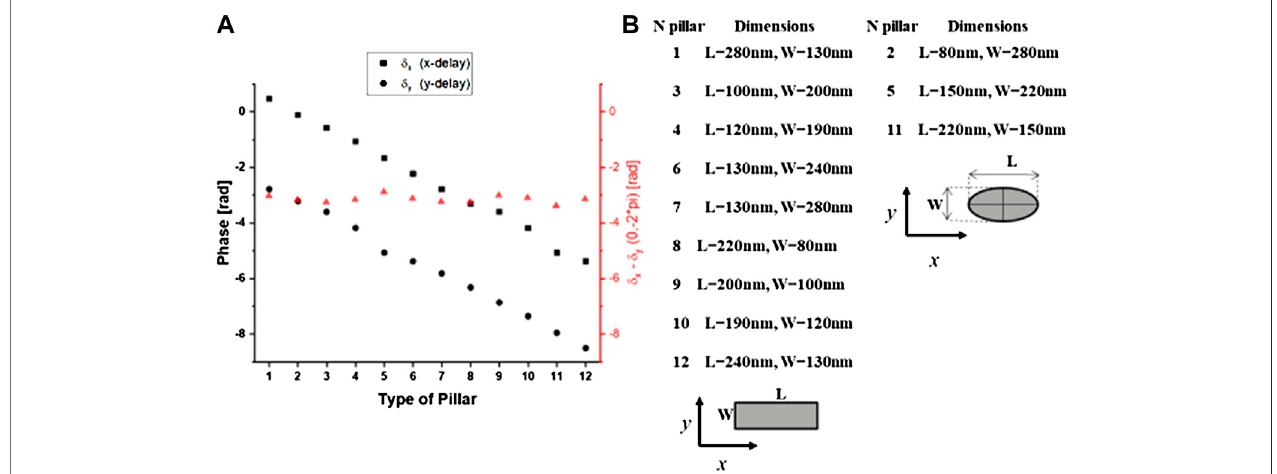
FIGURE 3 | (A) Graph showing the library of different pillars working at 775 nm and their phase delays under both TE polarization ( x -delay) and TM polarization ( y -delay), mandatory to built-up the metalens using the Eqs 7 – 9 . (B) List of pillars composing the library with their corresponding geometric features.